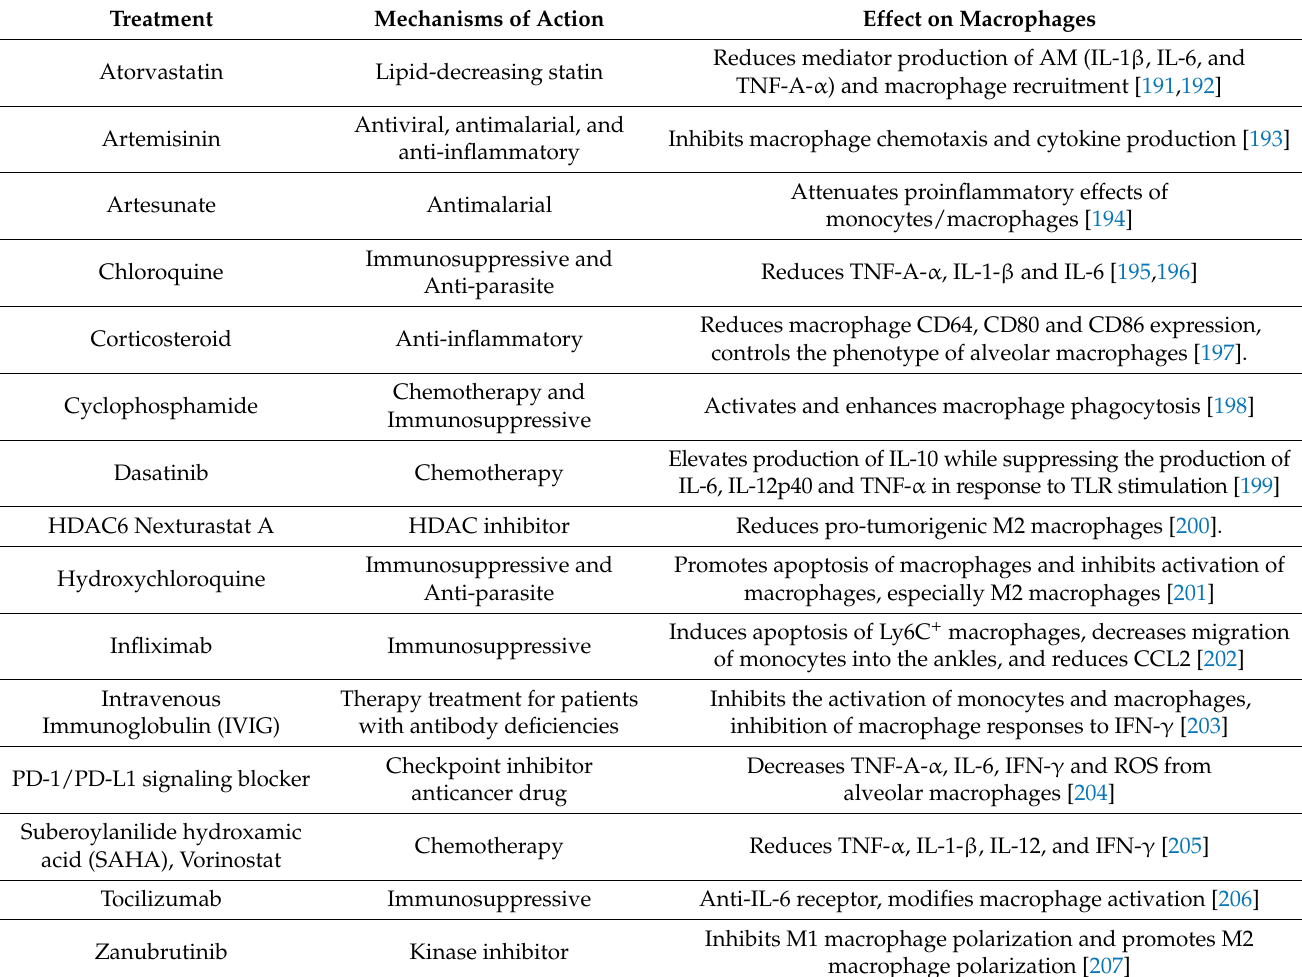
Table 1. Therapeutics that could ameliorated the fibrotic process via macrophage activation.